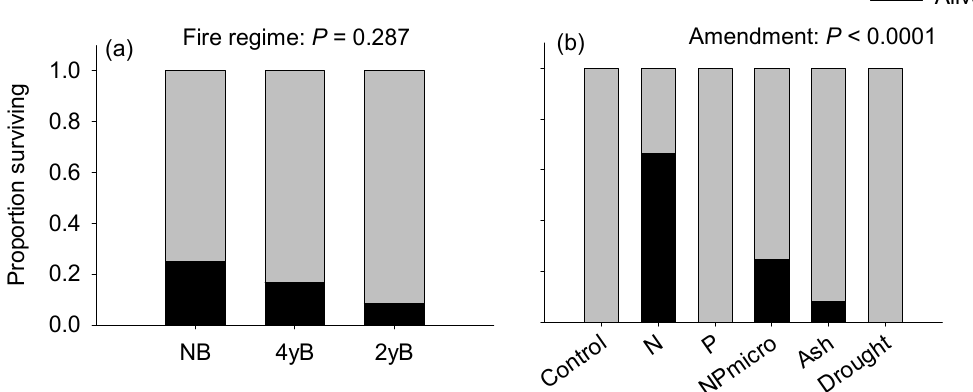
Figure 3. Proportions of pots with surviving or dead Imperata cylindrica seedlings at the end of the 219-day growth trial, contrasted among ( a ) soil fire regime treatments (NB = unburned; 4yB = quadrennially burned treatment; 2yB = biennially burned treatment; n = 24 for each level of fire regime) and ( b ) resource amendment treatments (control = no resource amendment; N = nitrogen addition; P = phosphorus addition; NPmicro = addition of N, P, and micronutrients together; ash = simulated ash deposition treatment; drought = treatment with lower levels of soil moisture; n = 12 for each level of resource amendment); p- values indicate the significance of fire regime (panel ‘a’) and resource amendment (panel ‘b’) as factors in binomial-distributed generalised linear models of survival (total number of observations = 72).